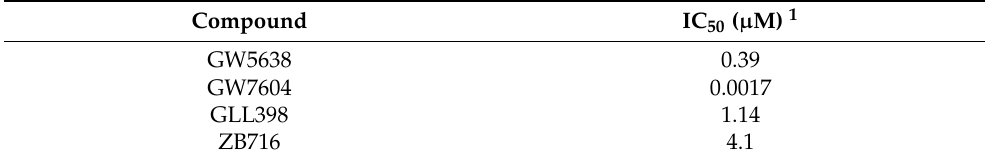
Table 2. The oral pharmacokinetic parameters of GLL398 and ZB716.